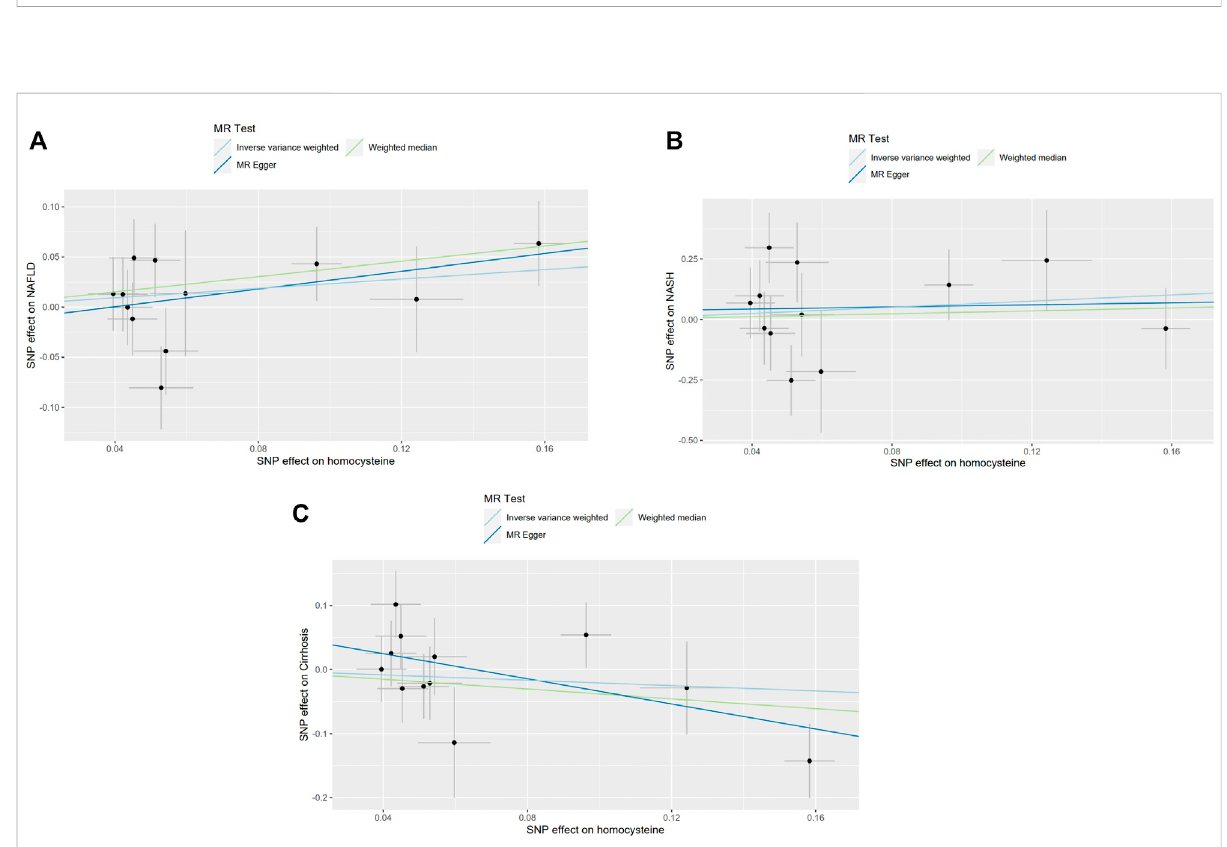
FIGURE 3 Single MR estimates from each of the genetic variants using IVW, WM and MR-Egger methods. The black scatter plots indicate single causal estimates fromeachofthegenetic variantsassociated with plasmahomocysteinelevel on the x -axisand theoutcomes, NAFLD,NASH and Cirrhosis on the y -axis. The continuous line represents the causal effect of plasma homocysteine on NAFLD, NASH, and Cirrhosis, separately. (A) . Non- alcoholic fatty liver disease (NAFLD); (B) . Non-alcoholic steatohepatitis (NASH); (C) .